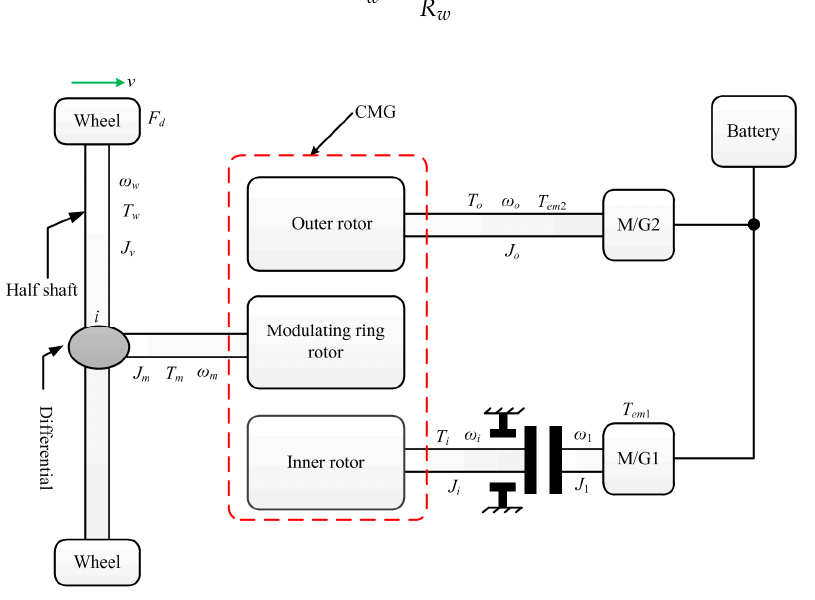
Figure 5. Powertrain system diagram.